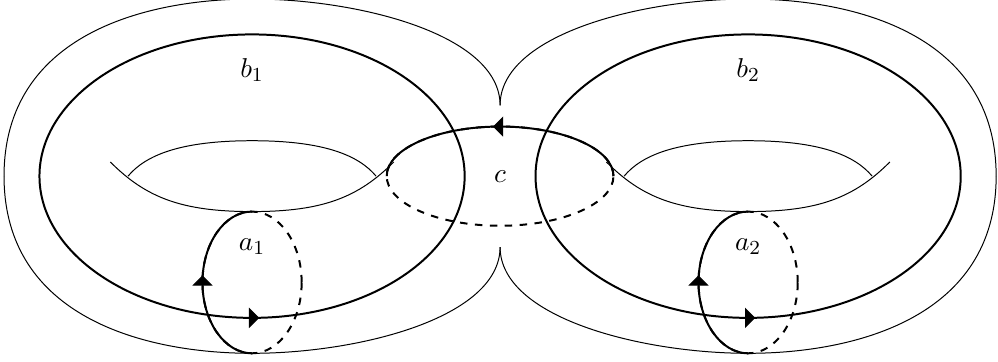
Figure 1 . A genus two Riemann surface, with 5 oriented homotopy